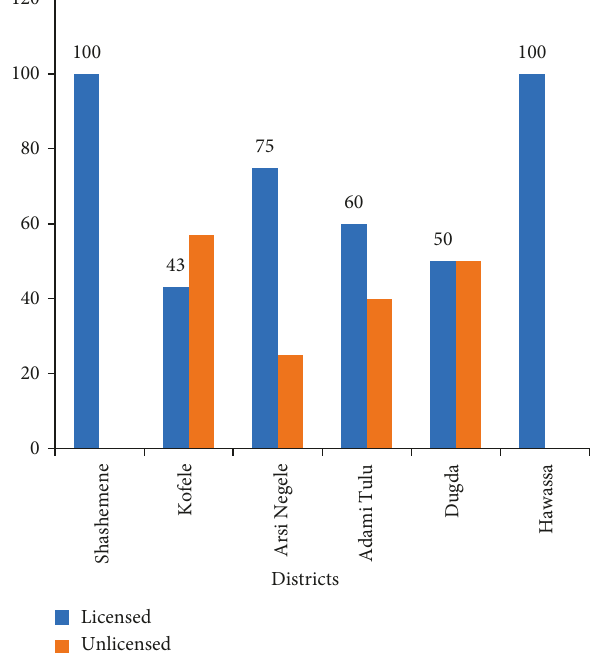
Figure 2: Proportion of licensed and unlicensed milk collectors in the shed.